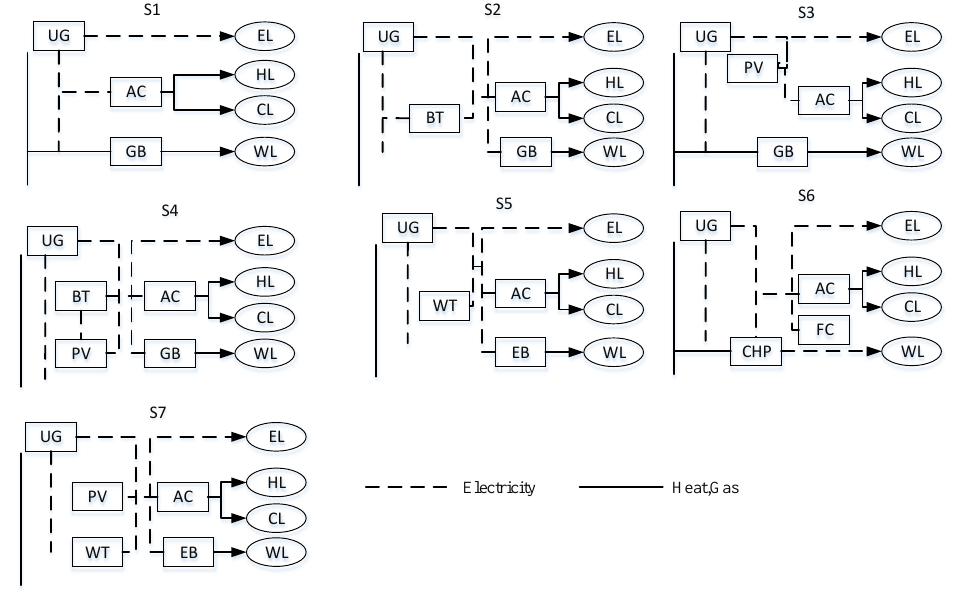
Figure 2. Energy flow of various systems. Table 2. Basic data of the seven